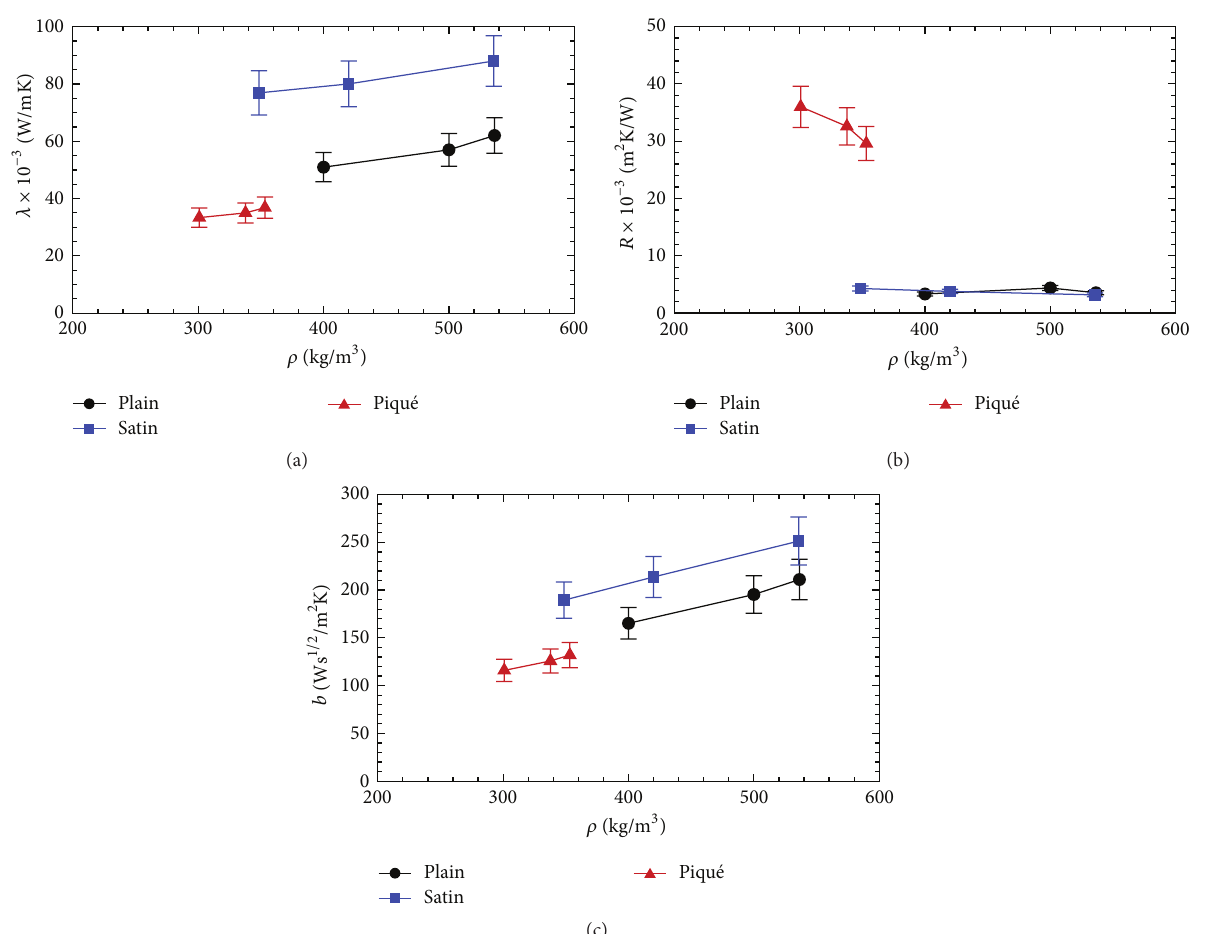
Figure 6: CO fabrics thermal properties versus density: (a) thermal conductivity, (b) resistance, and (c)